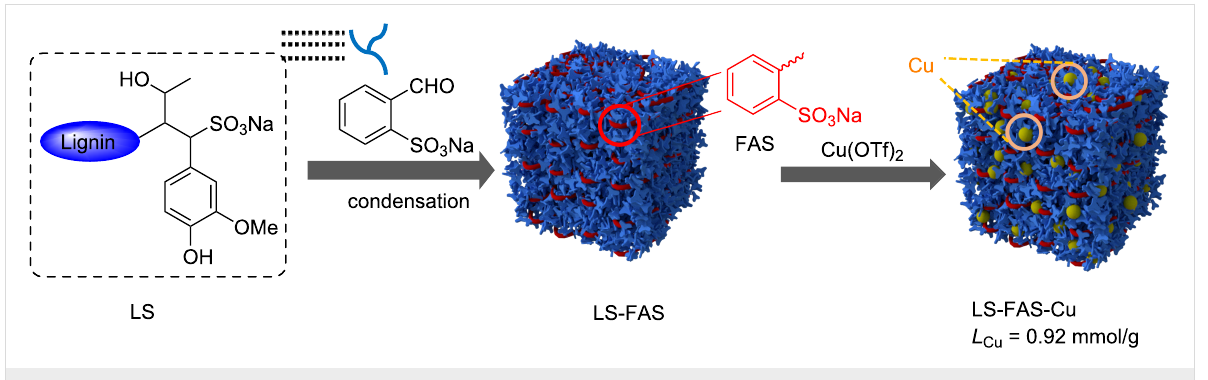
Figure 1: Schematic illustration for the preparation of the catalyst in this